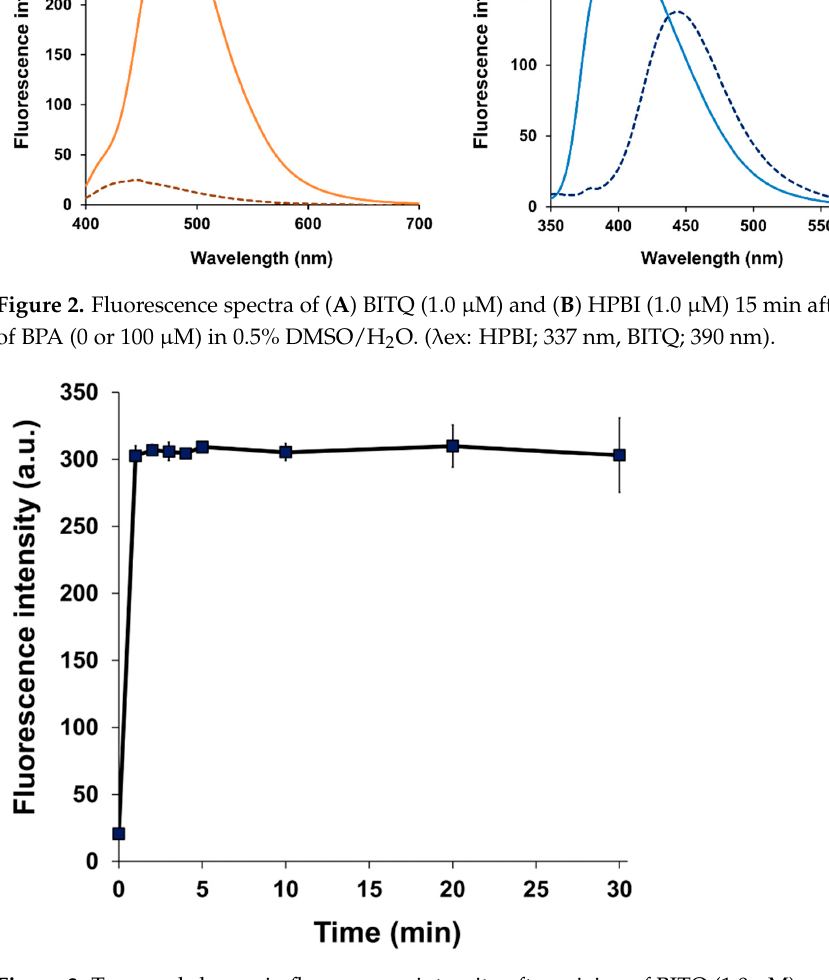
Figure 4. Linear regression analysis between the fl uorescence intensities of BITQ (1.0 µM) and BPA concentrations treated (0–50 µM) in 0.5% DMSO/H 2 O. ( λ ex = 390 nm, λ em = 480 nm). 3.2. Selectivity Assay The changes in the fl uorescence of BITQ (1.0 µM) after adding various metal cations (100 µM) are summarized in Figure 5. The BITQ fl uorescence signi fi cantly increased after adding BPA (>200%) but did not increase after adding any of the metal cations tested ex- cept for Zn 2+ (130%, not signi fi cant).